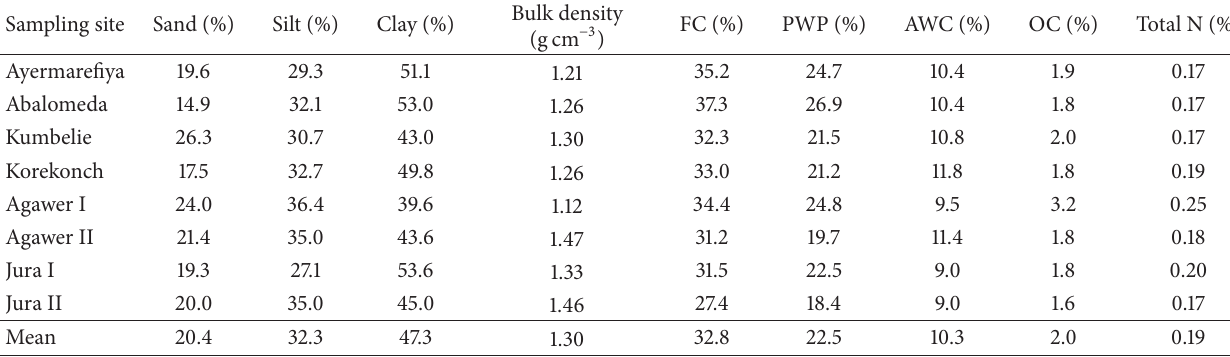
Table 2: Selected physical properties of the studied soils.